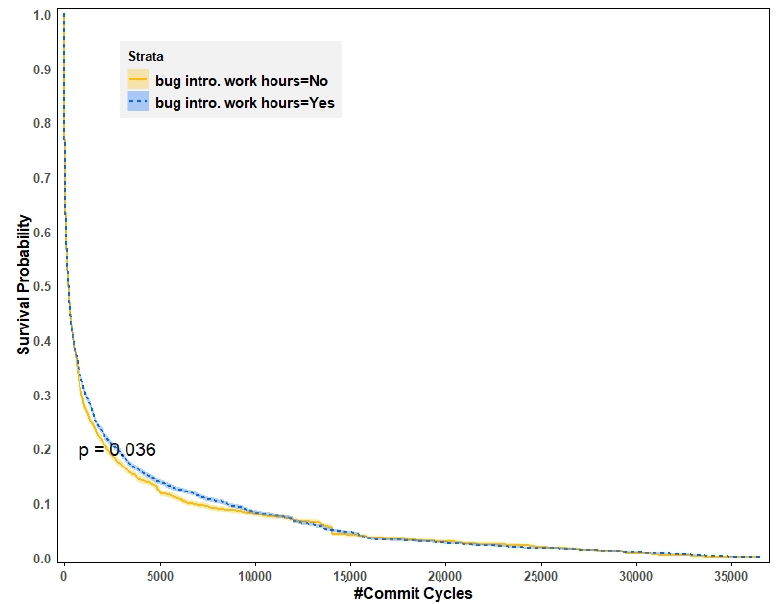
Figure 3. Kaplan–Meier estimations of the survival function for the scenario when bugs are intro- duced during work hours and vice